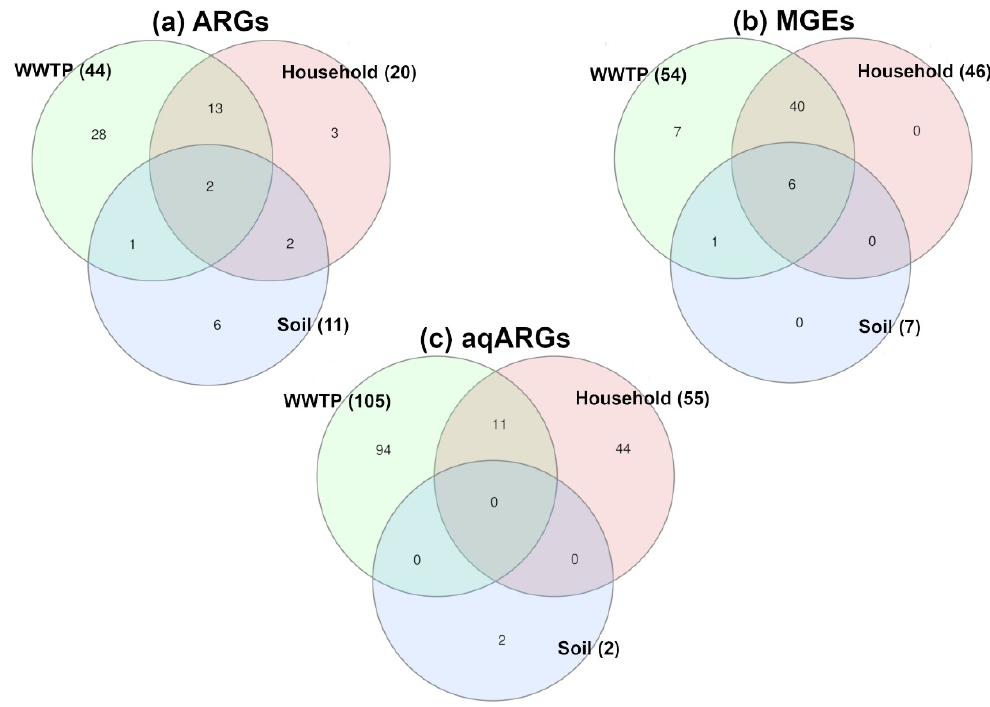
Figure 6 . Venn diagram of antibiotic resistance genes (ARG) ( a ) and mobile genetic elements (MGE) ( b ) annotated using MvirDB as well as acquired antibiotic resistance genes (aqARG) ( c ) annotated using Resfinder in the WWTP, soil and HH samples. The number in the bracket indicates the total number of genes annotated for each sample type.